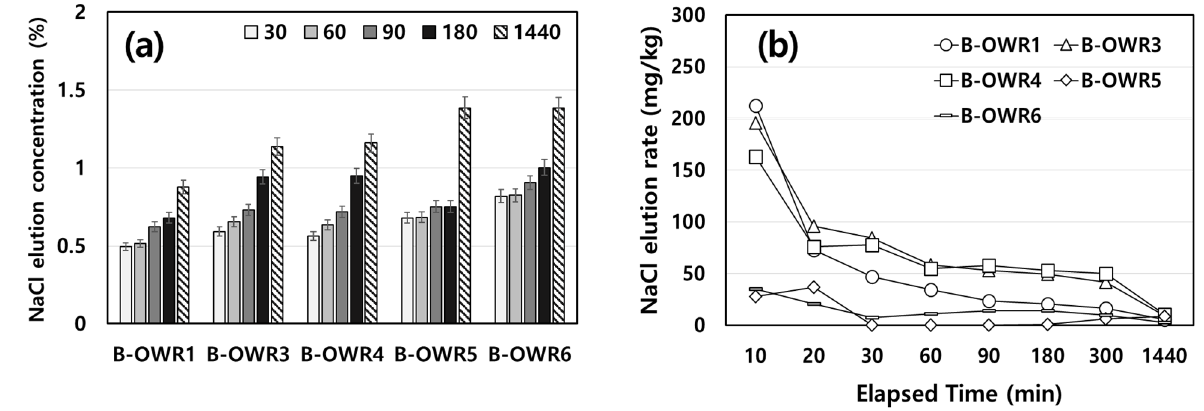
Figure 2. Neglected-oyster shell to water ratio (OWR) depending on elution time. ( a ) NaCl elution concentration and ( b ) NaCl elution rate. B-OWR, batch-oyster shell to water ratio.